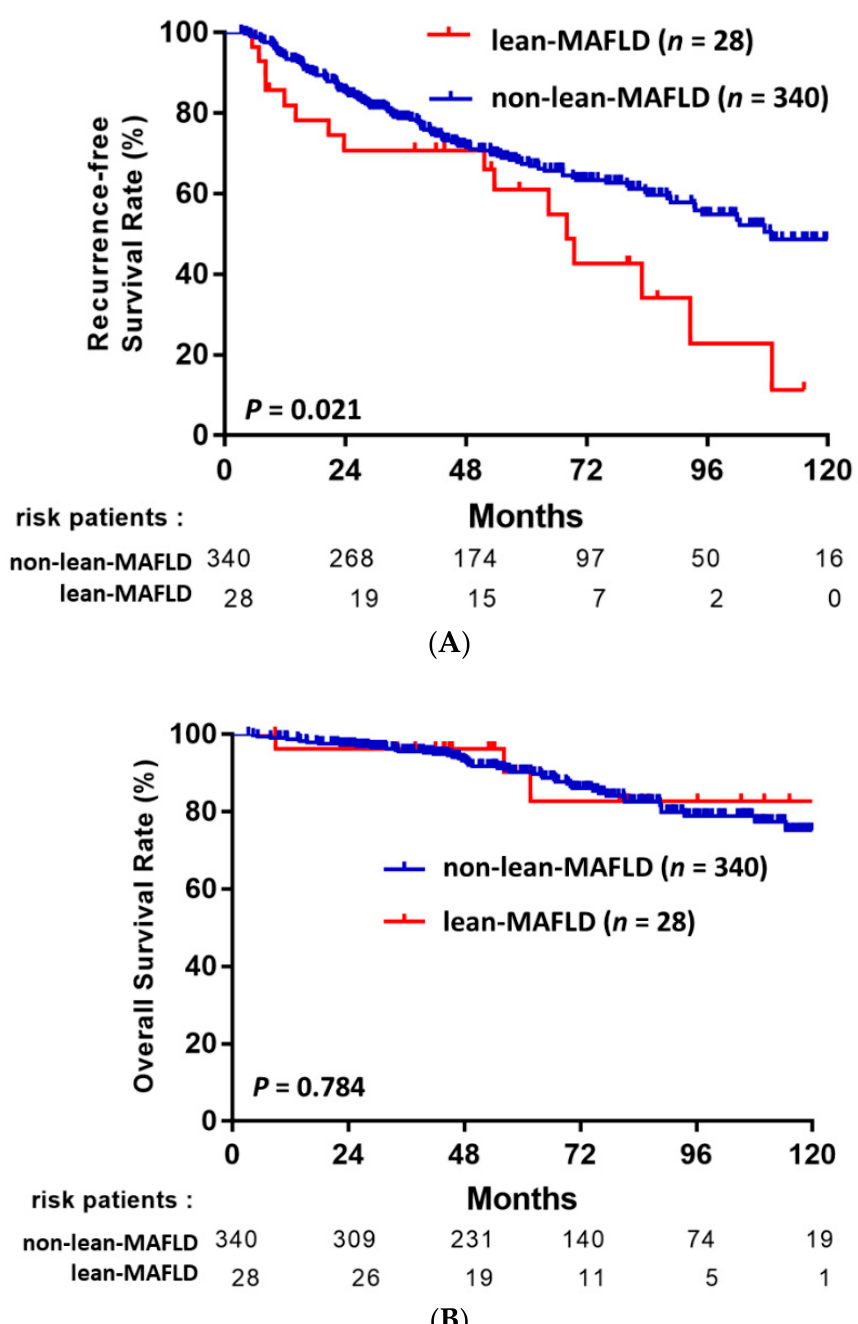
Figure 4. RFS ( A ) and OS ( B ) in HBV-MAFLD-HCC patients after curative resection stratified by the lean-MAFLD and non-lean-MAFLD subgroups.